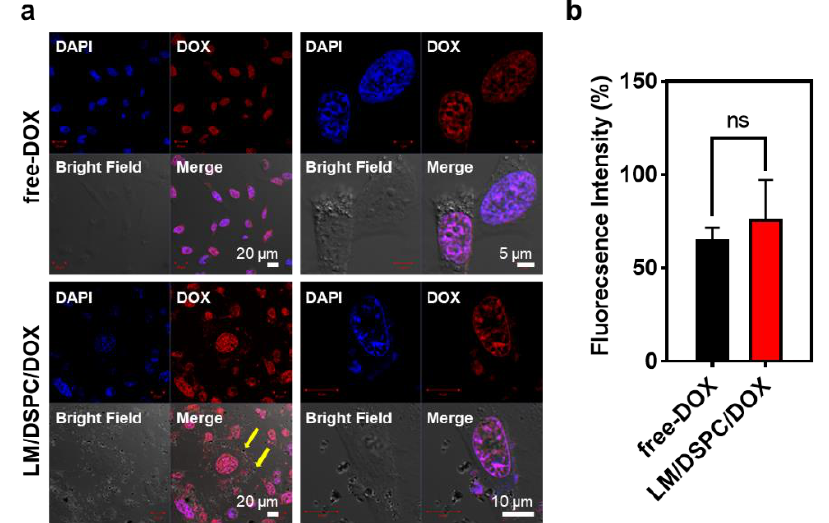
Figure 3. The cellular uptake of doxorubicin (3 µ g / mL) and LM / DSPC / DOX particles. ( a ) Confocal microscopy of MDA-MB-231 breast cancer cells after an 8 h incubation with doxorubicin (red) and LM / DSPC / DOX particles (red). The nuclei were stained with (4 (cid:48) ,6-Diamidine-2 (cid:48) -phenylindole dihydrochloride) DAPI (blue). ( b ) Fluorescence intensity comparison verifying cellular uptake e ffi cacy ( p = 0.2748). (ns = no